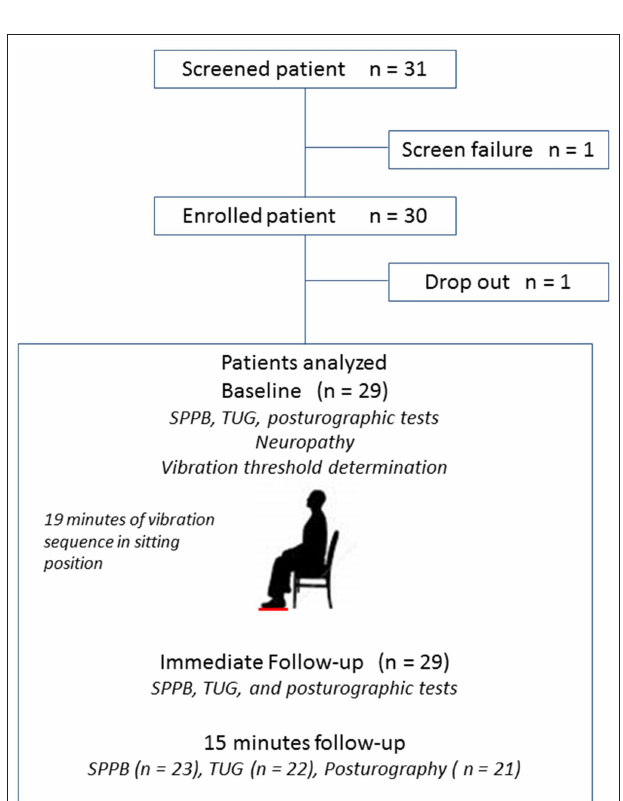
FIGURE 2 | Study Flow diagram and design. Patient numbers at each stage of the study. SPPB, Short Physical Performance Battery; TUG, Timed Up and Go